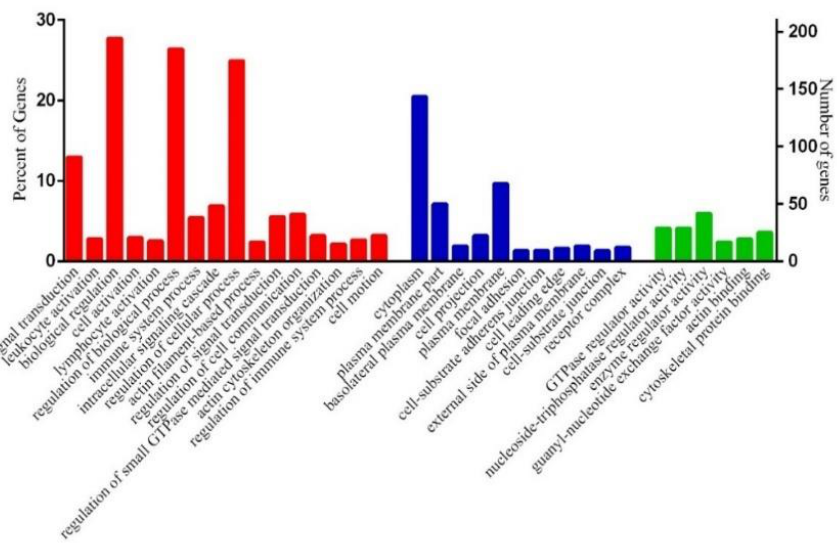
Figure 4. Histogram of gene ontology (GO) classification. The terms are summarized in three categories, biological process (red), cellular component (blue) and molecular function (green), for upregulated DEGs (corrected p- values ≤ 0.05). Table 4. Most significantly enriched KEGG pathways.